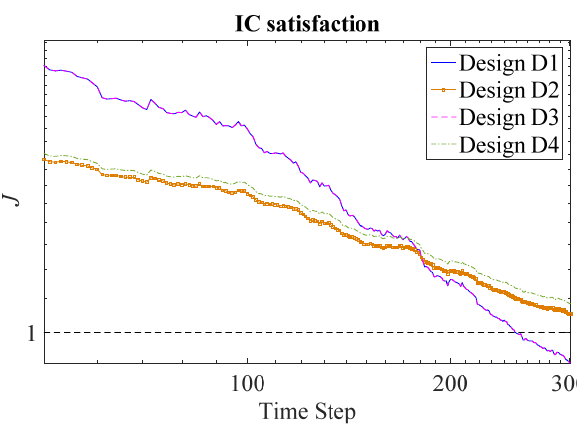
Figure 10. Identification time required for satisfaction of IC for a two-stage absorber when inputs are produced from designs D1–D4. (Equation (44)) for D1 and D3; (Equation (21)) for D2 and D4.